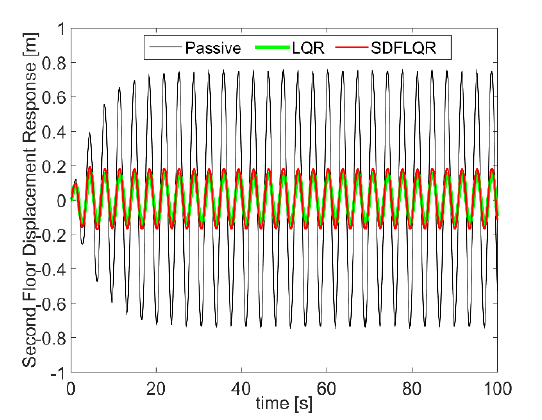
Figure 3. Controlled and uncontrolled displacemet time responses of second floor of offshore steel jacket platform.